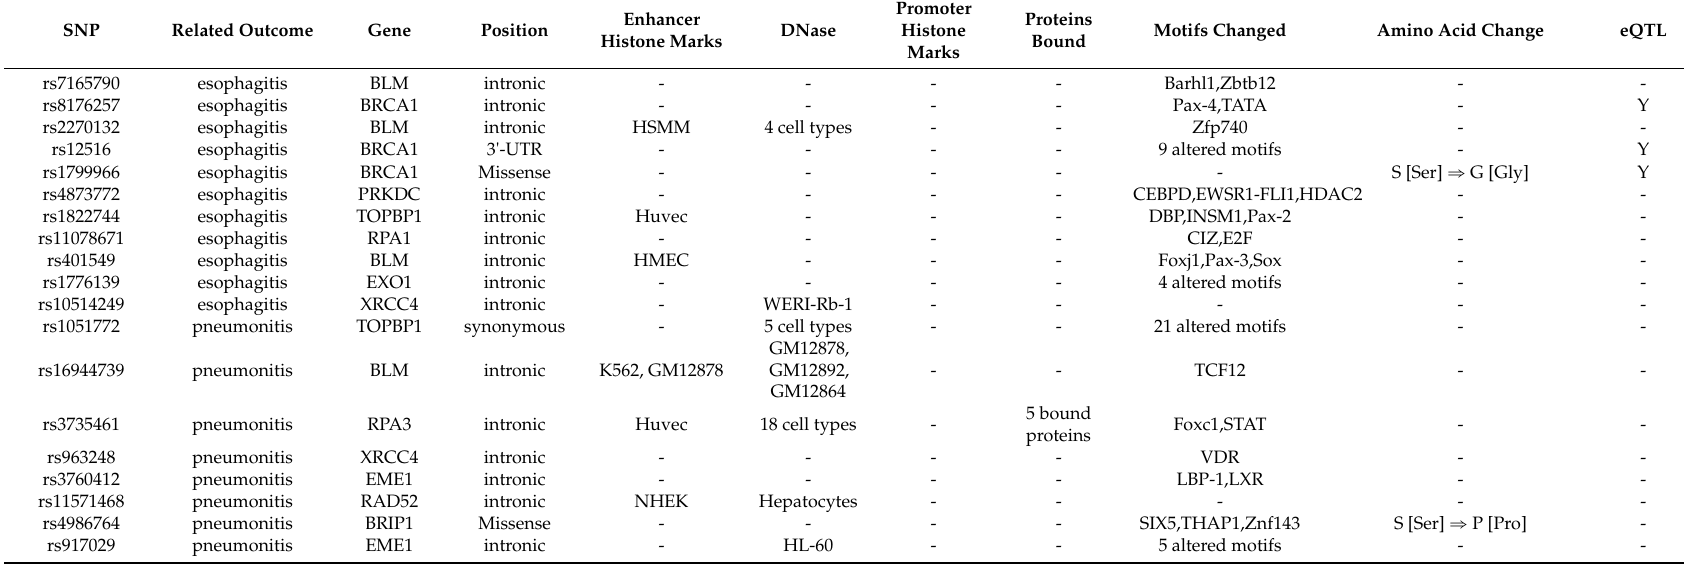
Table 5. SNP function